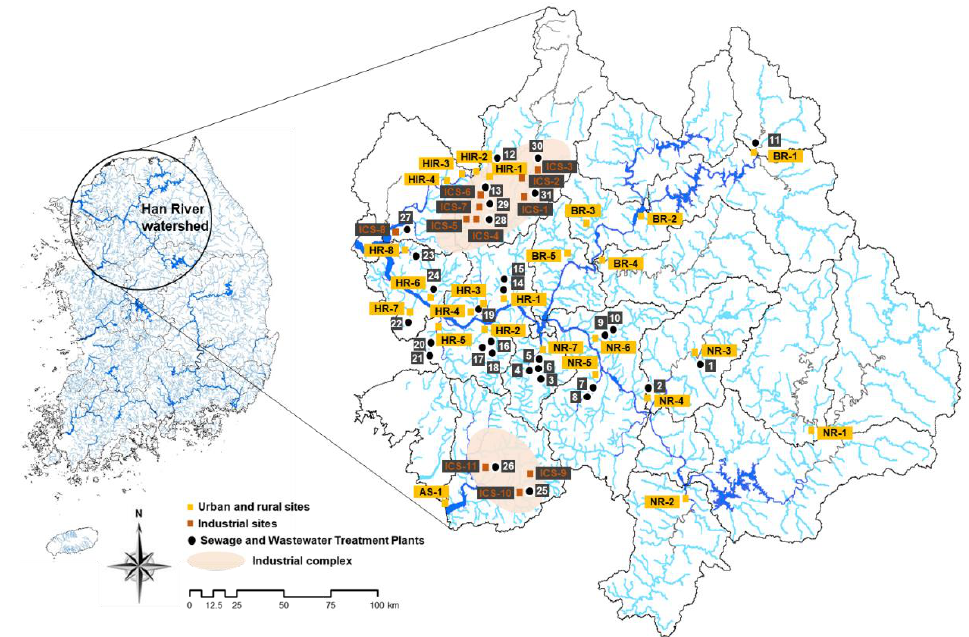
Figure 1. Location of sampling sites in the study